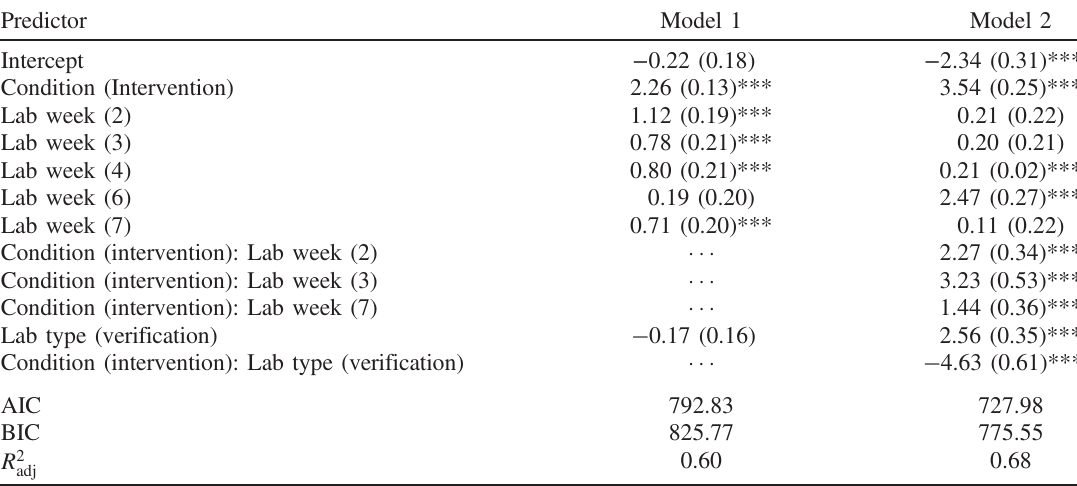
TABLE V. Linear regression analysis for the total number of coded behaviors across conditions, lab weeks, and lab types (evaluation or verification). The variable estimate is listed with its standard error for models with and without interaction terms. The base is a student in the control condition, in an evaluation lab, in week 1. Note that the interaction terms between condition and time for weeks 4 and 6 are exactly redundant with interactions with condition and lab type, and so are omitted from the regression.